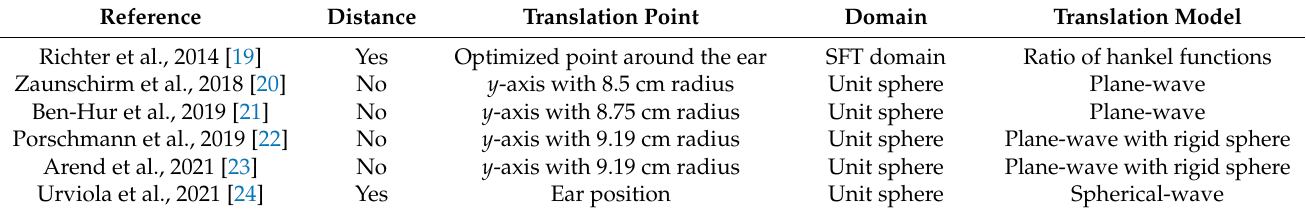
Table 1. Overview of previous research in translation operators for ear centering in HRTF synthesis.